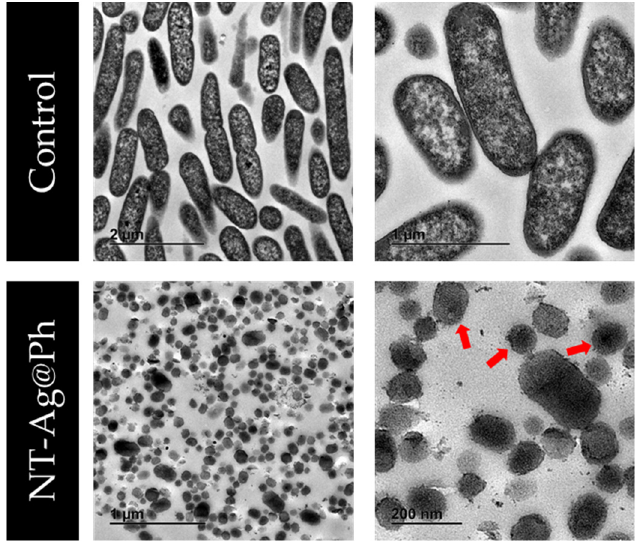
Figure 6. TEM images of P. aeruginosa ATCC27853 treated with 0 (control) and 2 mg/mL of NT-Ag@Ph . Red arrows indicate elements compatible with membrane vesicles.